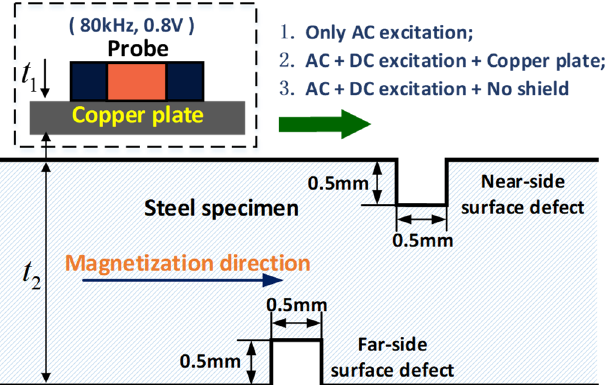
t and t represent the thickness of the copper plate 1 2